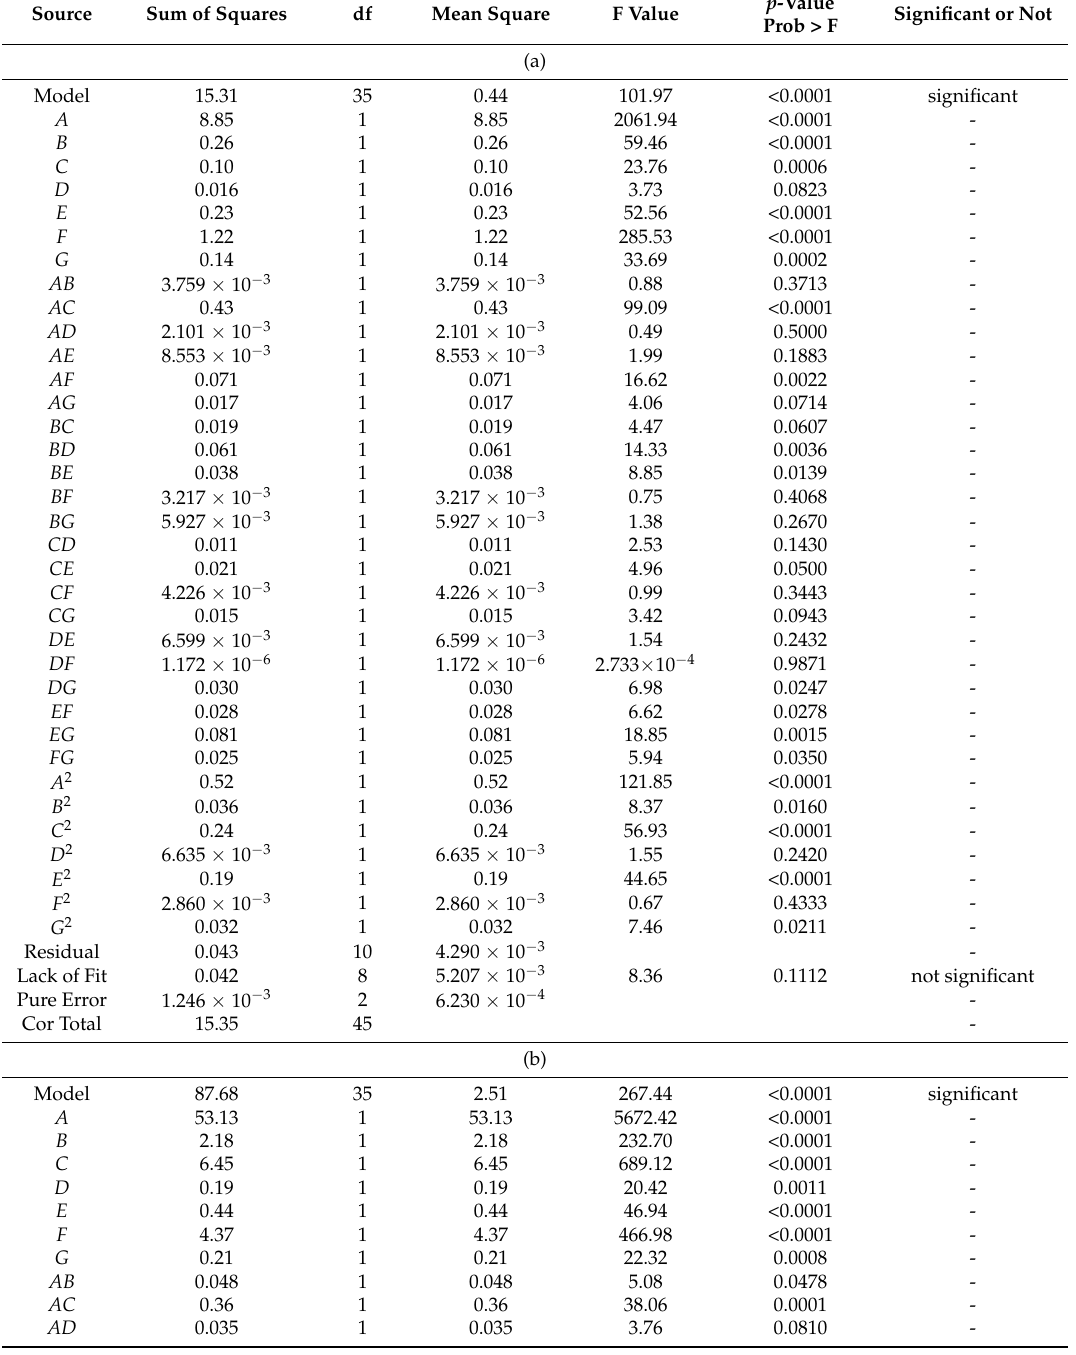
Table 5. (a) ANOVA for GRR in short-term response surface with quadratic model. (b) ANOVA for GRR in long-term response surface with quadratic